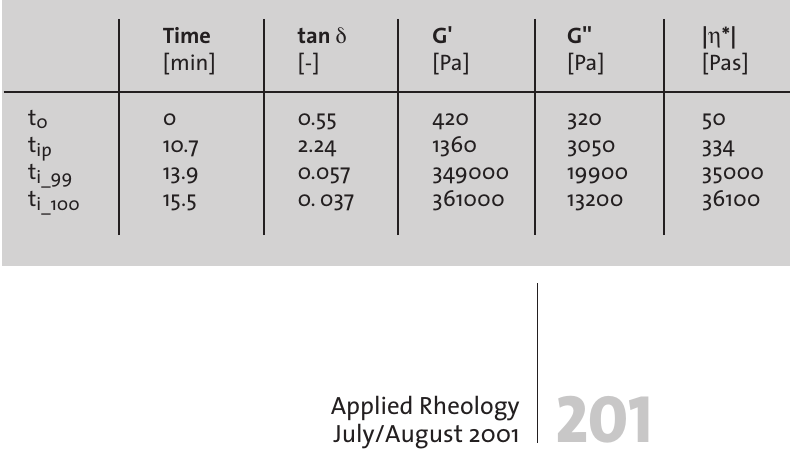
Table 1: Specific points in the dewatering process of a